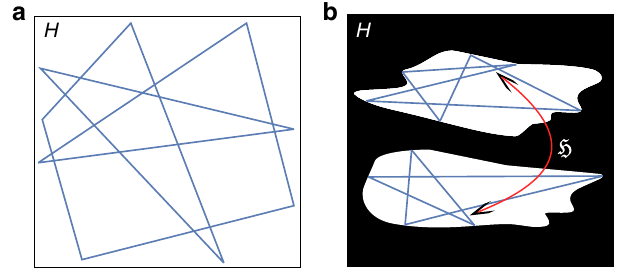
Fig. 1 The Hilbert space H separated into a decaying part (black) and a nondecaying part (white). a Ergodic time evolution, indicated by a blue trajectory, explores the entire connected nondecaying space thus leading to stationarity of observables after a transient period. b Dissipation may split the nondecaying part into disjoint sectors. The dark Hamiltonian H drives transitions between them. Observables that are not entirely contained